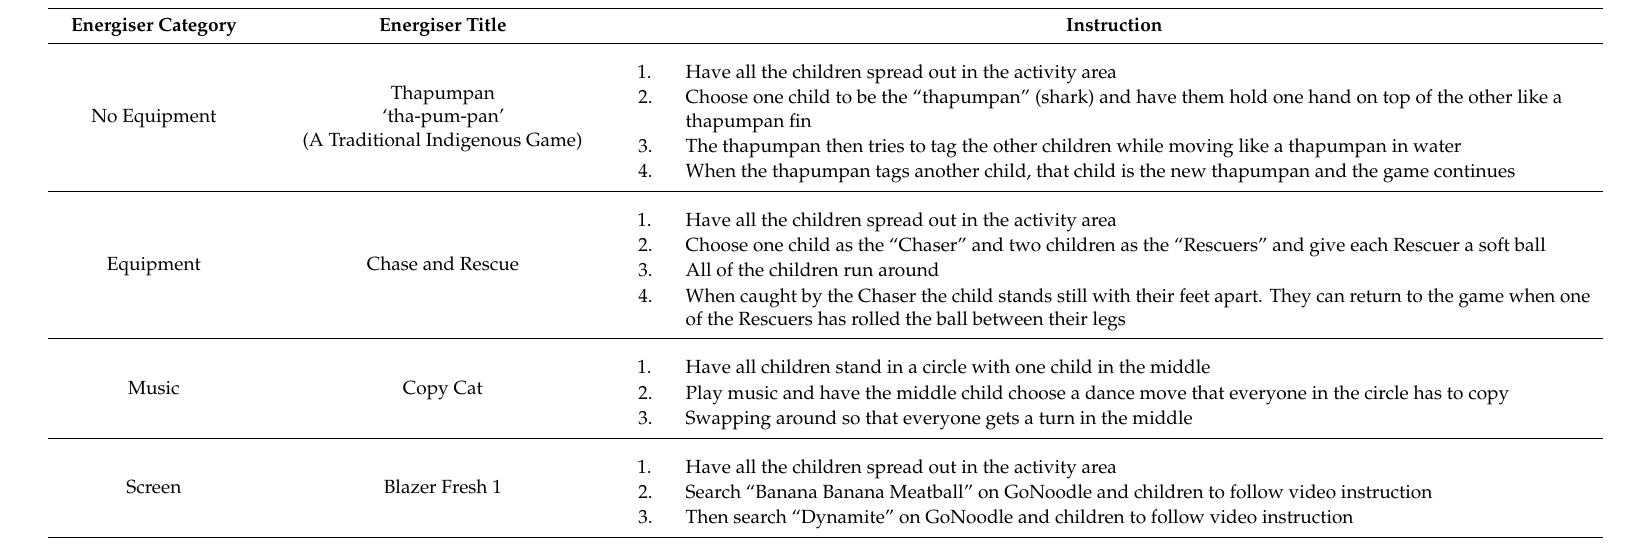
Table 1. Example of Energiser Activity Cards.